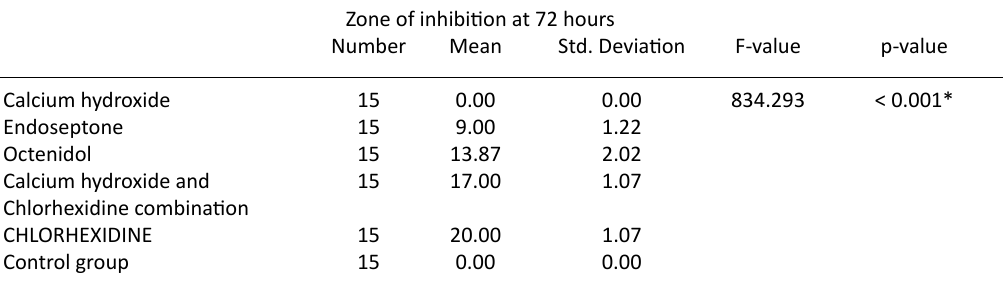
Table 3. Zone of inhibition at 72 hours